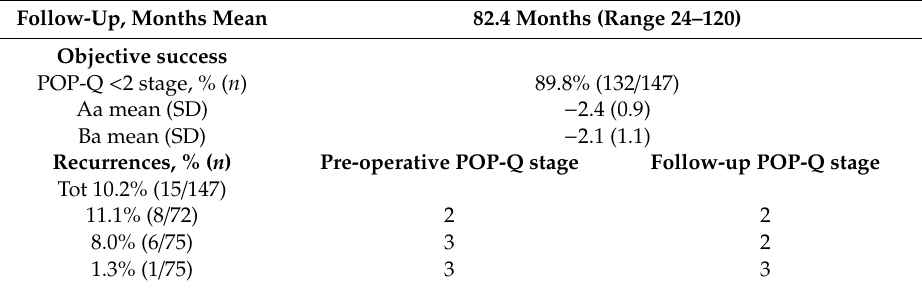
Table 2. Patient outcomes.